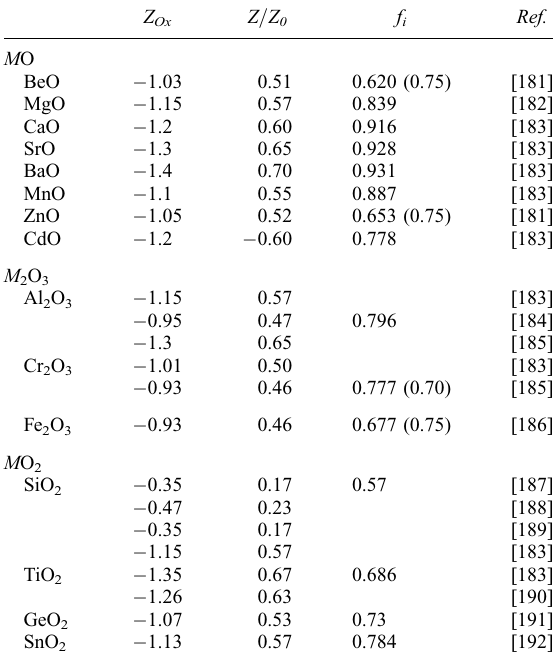
TABLE VIII (a) Effective Charges in Binary Oxides and Comparison of Reduced Effective Charge with Levine’s Ionicity f i .